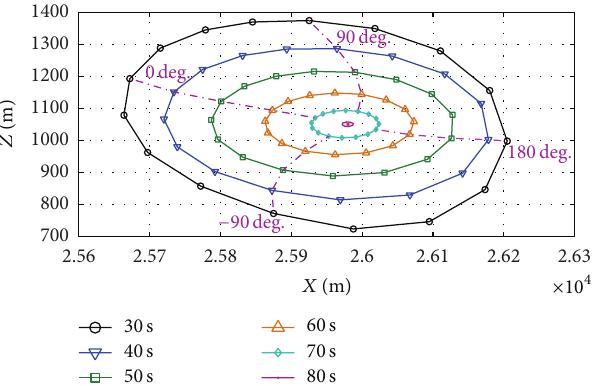
Figure 14: Correction